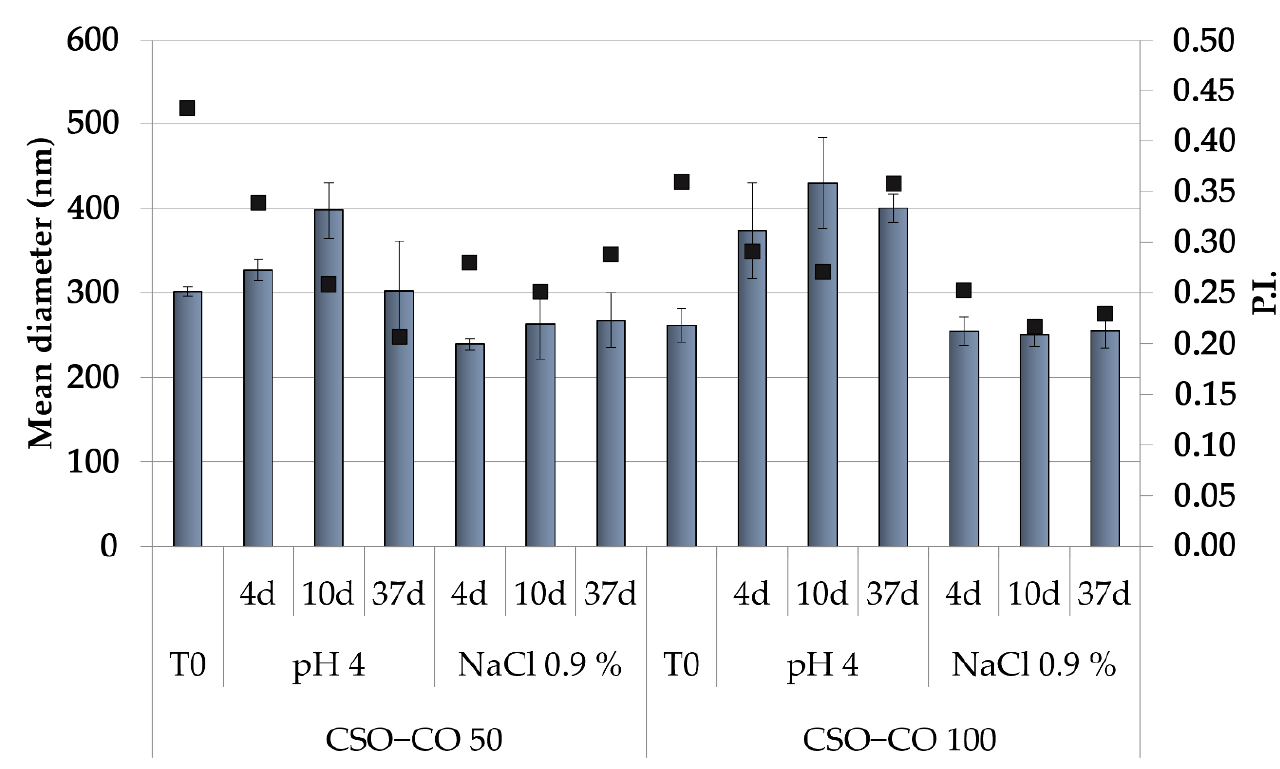
Figure 2. Dimensions (histogram bars) and PI (black symbols) of CSO–CO 50 and CSO–CO 100 maintained in acidic pH and saline solution (NaCl 0.9% w / v ) after different times up to 37 days (mean ± sd; n = 3).